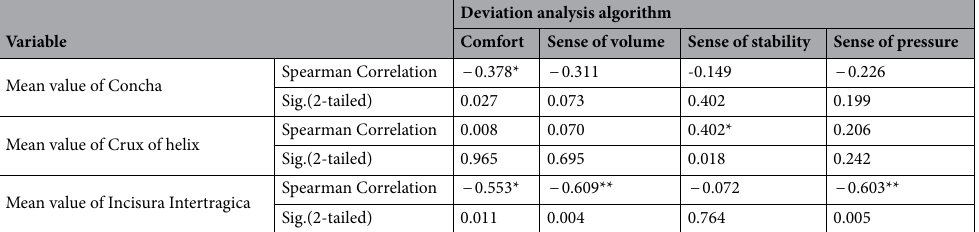
Deviation analysis algorithm Comfort Sense of volume Sense of stability Sense of pressure